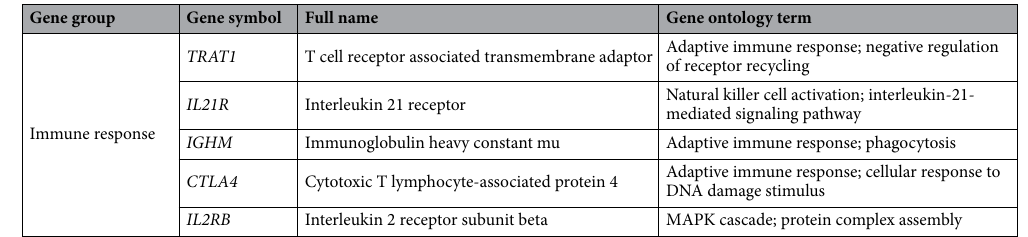
Table 2. The five prognostic immune response related genes used to calculate the immune prognostic